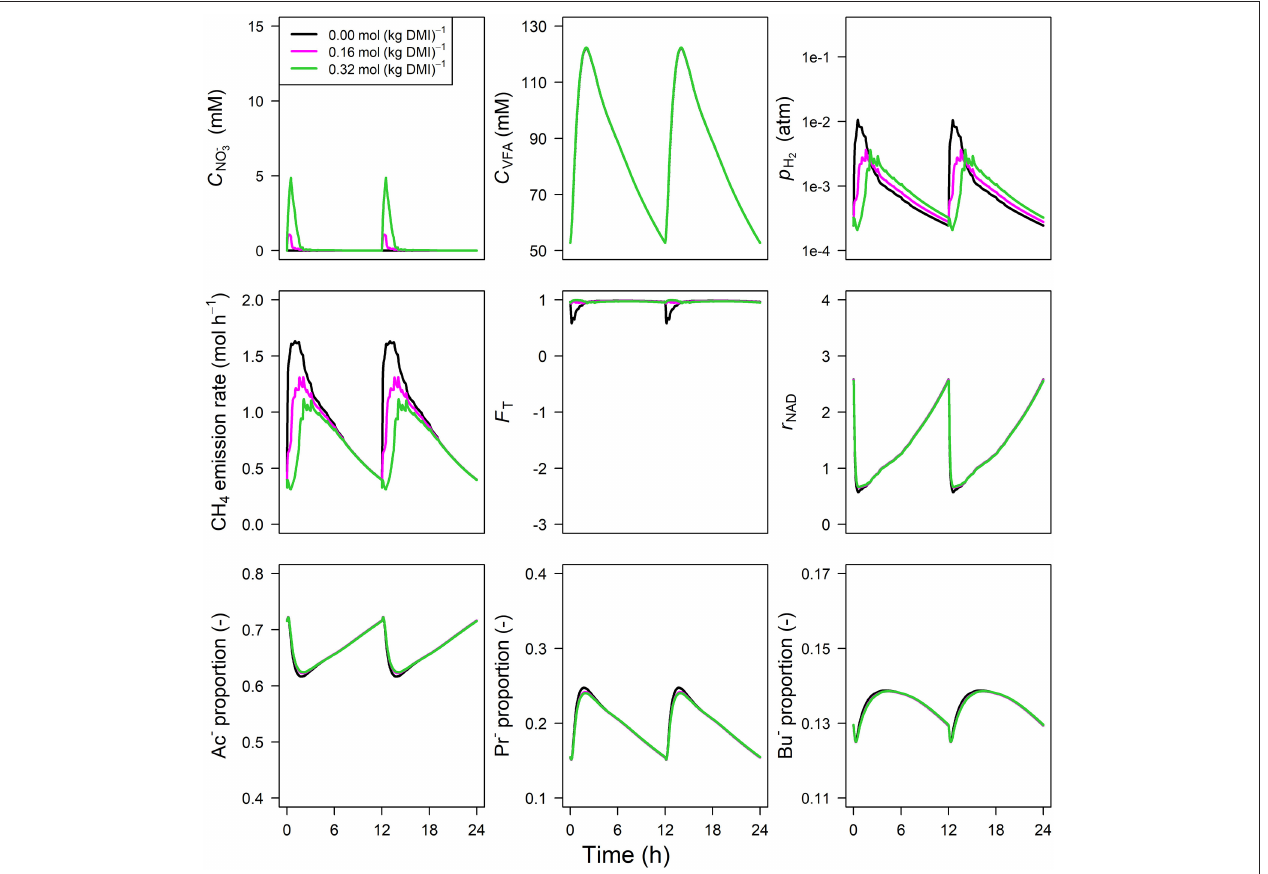
FIGURE 5 | Solutions of the NO – 3 dynamic model without NO – 2 representation for NO – 3 concentration [mM], VFA concentration [mM], rumen headspace p H emission rates [mol · h − 1 ], thermodynamic potential factor ( F T ; [–]), NAD + to NADH ratio ( r NAD ), acetate proportion (Ac – ), propionate proportion (Pr – ), and butyrate proportion (Bu –